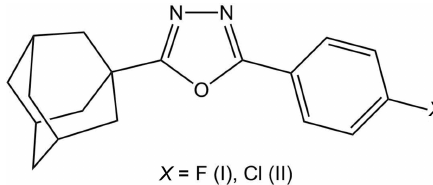
Table 2 Hydrogen-bond geometry (A˚ , (cid:3) ) for